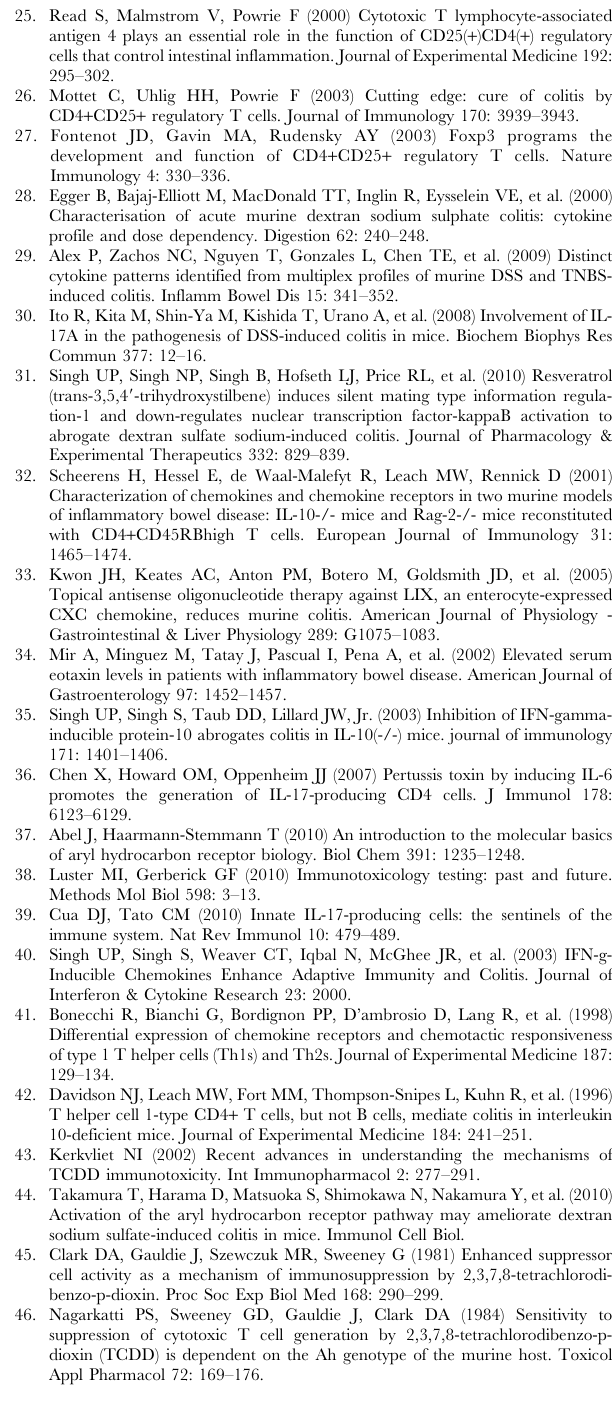
Figure S1 TCDD mediated reduction of serum cyto- kines and chemokines in DSS- induced colitis. Colitis was induced in mice that were exposed to VEH or 25 m g /kg body weight of TCDD as described in the legend to Fig 1. Serum cytokines and chemokines were measured 14 days after the DSS induction of colitis by ELISA assay. The data presented are the mean concentrations from 6 mice 6 SEM in serum. Asterisks